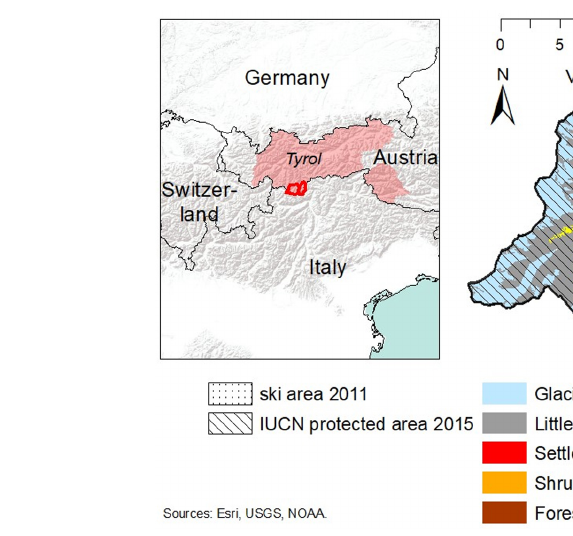
Fig. 2 . Overview of case study sites, land use, and land cover as of 2015 (adapted from Huber et al.